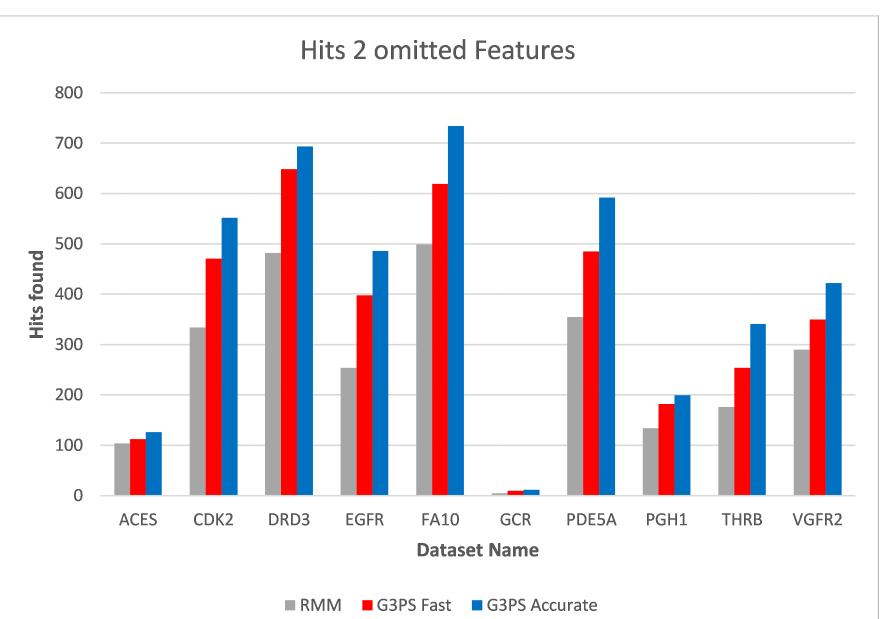
Figure 15. Screening benchmark hits with two omitted